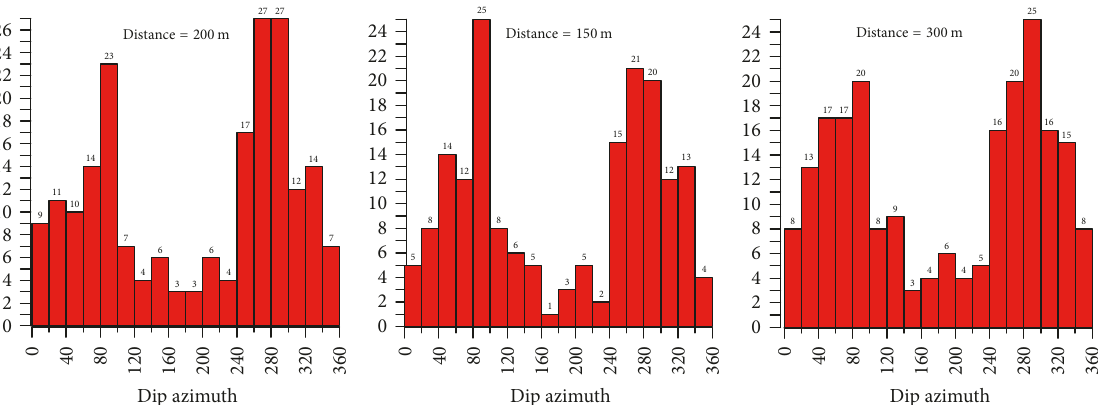
Figure 36: Histograms of the Frac-Digger sensitivity of the estimated dip azimuths of dikes to the distance from the event to the plane ( 𝛿𝑍 ).